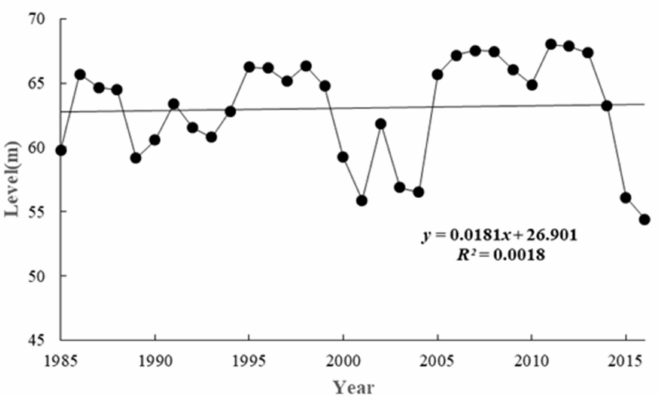
Figure 2. The annual variation of average water level in Biliuhe reservoir